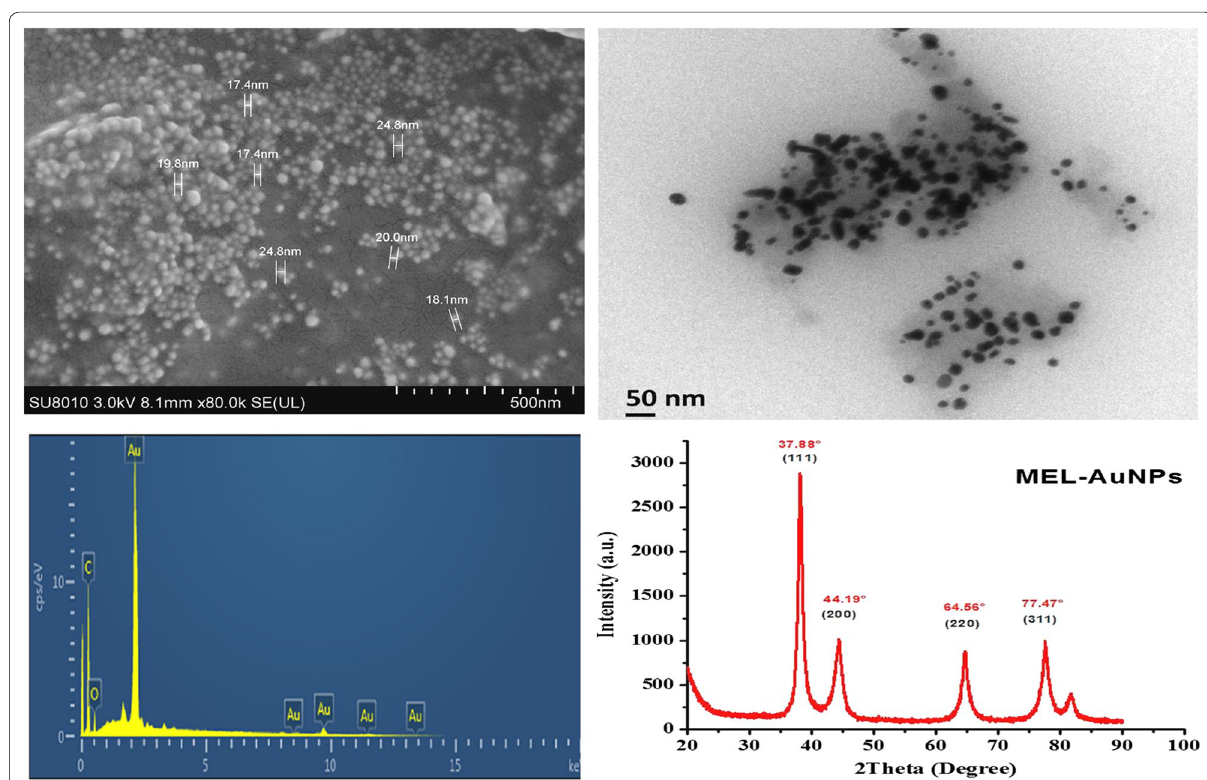
Fig. 3 Characterization of biosynthesized AuNPs using MEL a SEM image; b TEM image; c EDX pattern; and d XRD pattern